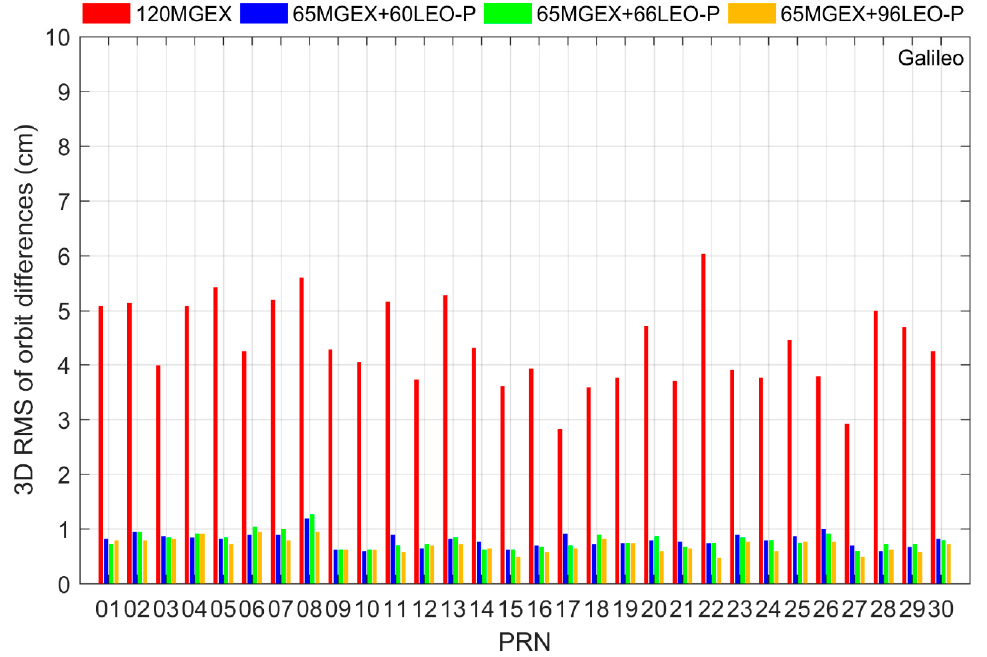
Figure 5. Average 3D RMS values of Galileo orbit differences for the integrated POD with different numbers of LEO satellites.